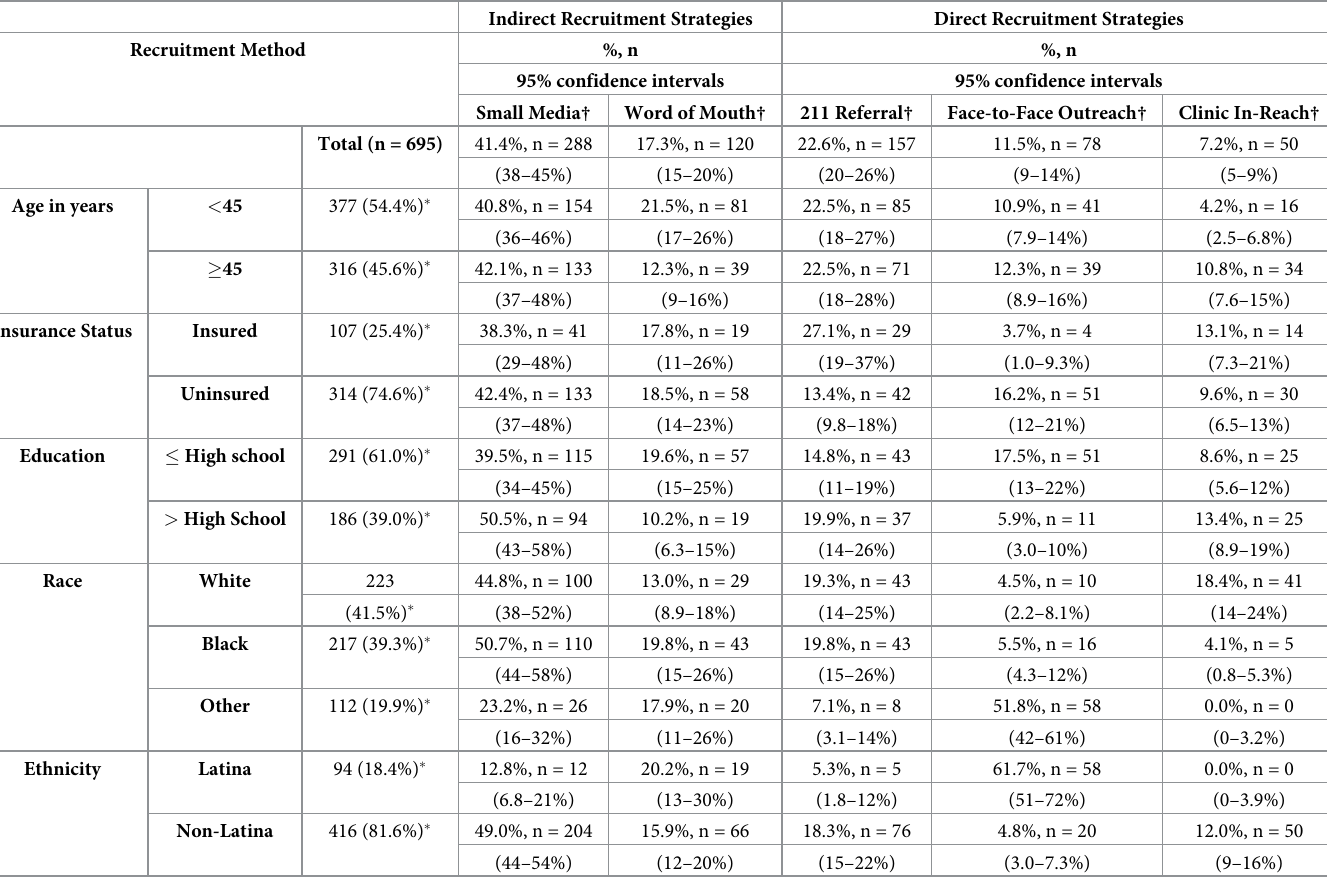
Table 2. Proportions of study-eligible participants’ recruited into the in my body my test phases 1 and 2 study, stratified by demographics of eligible